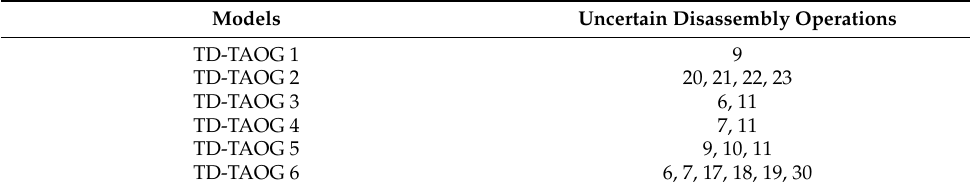
Table 4. Disassembly operations that may be in the damaged or missing state.